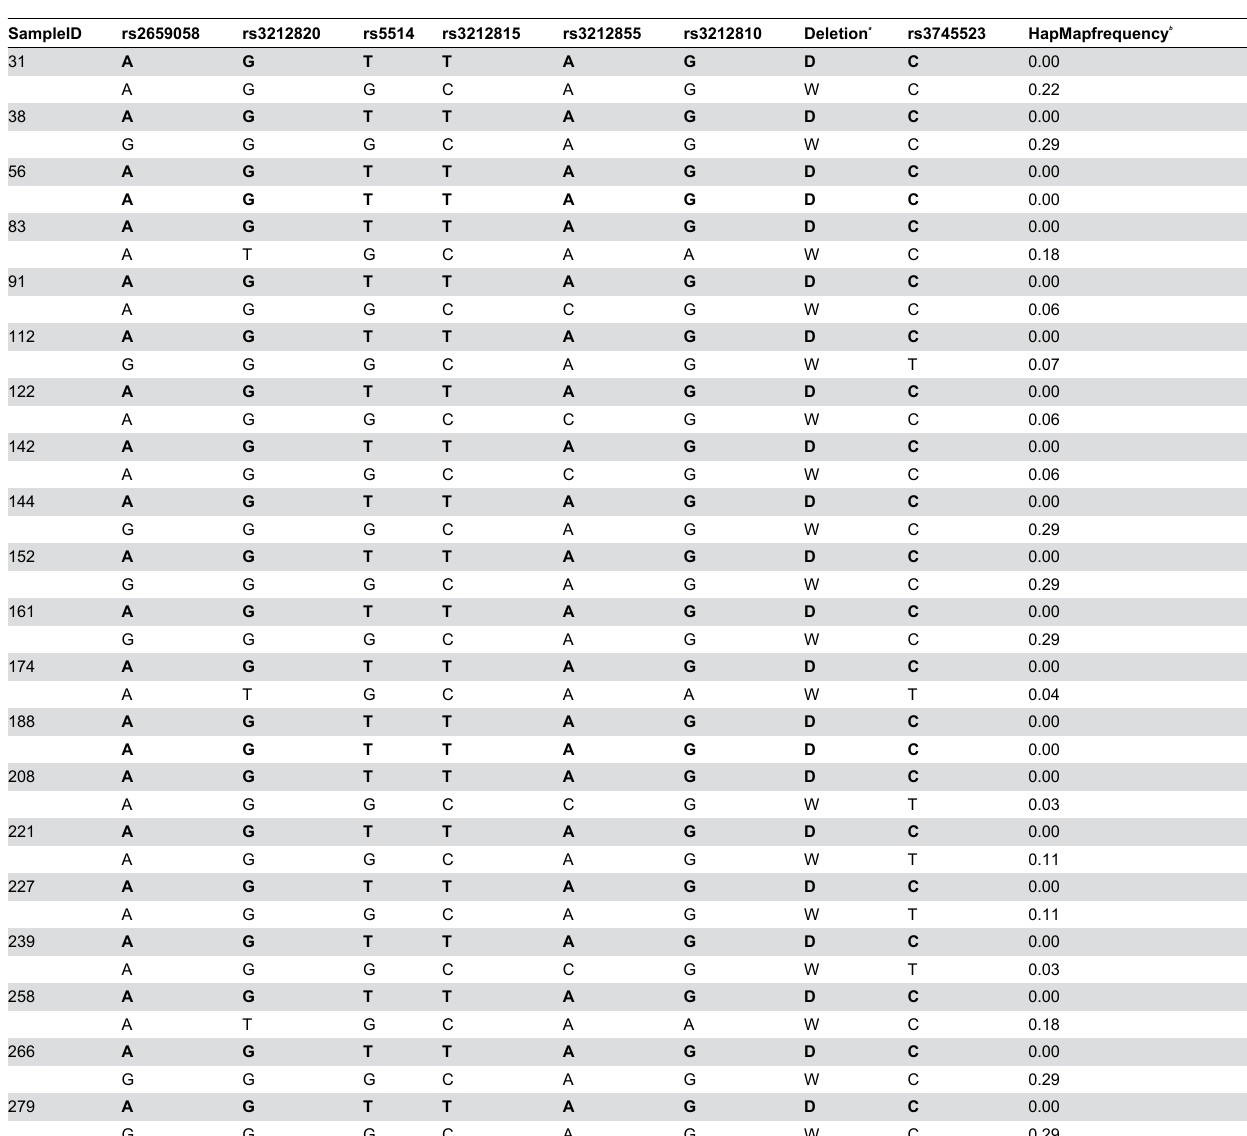
Table 2. Haplotypes estimated in individuals carrying deletions in the KLK15